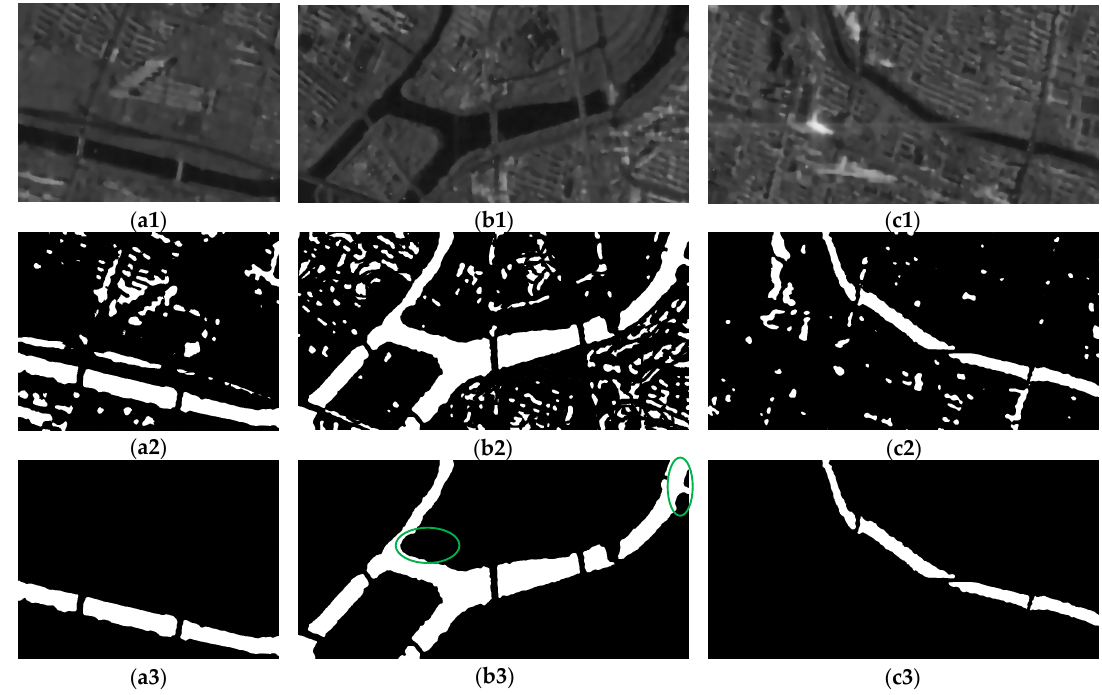
Figure 6. Results of each step. ( a1 )–( c1 ) Filtering result. ( a2 )–( c2 ) Sauvola algorithm segmentation results. ( a3 )–( c3 ) Extraction results of riverway